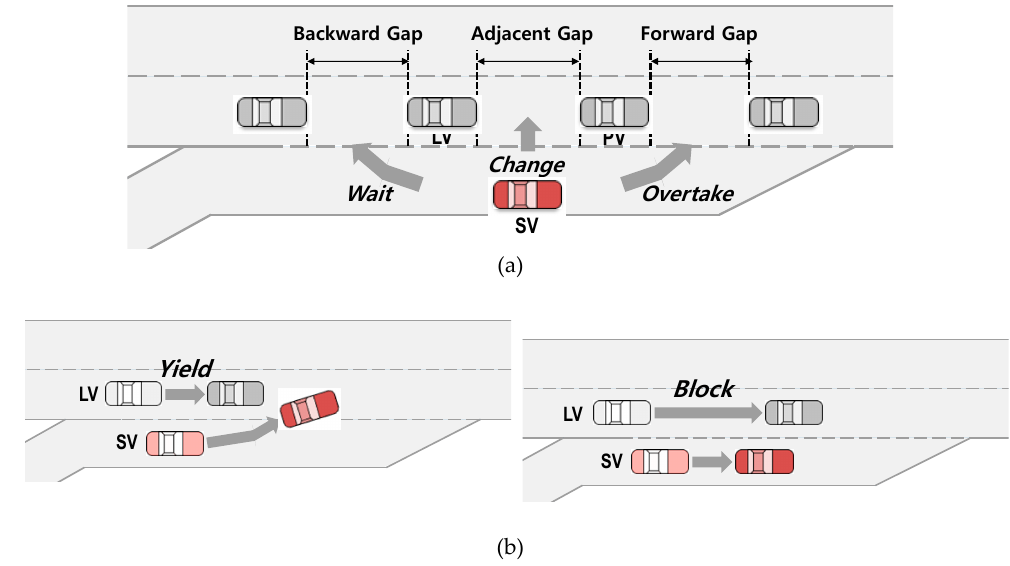
Figure 1. Players’ strategies for merging maneuver: ( a ) the driver of subject vehicle (SV); ( b ) the driver of lag vehicle (LV).